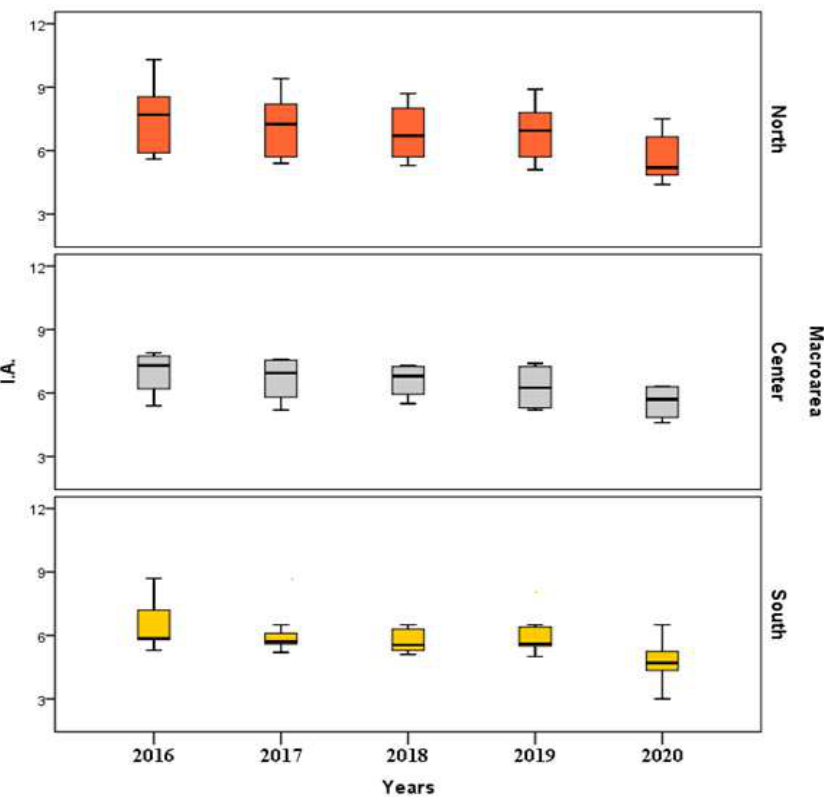
Figure 3. Boxplots of standardized rates of SA (2016–2020).